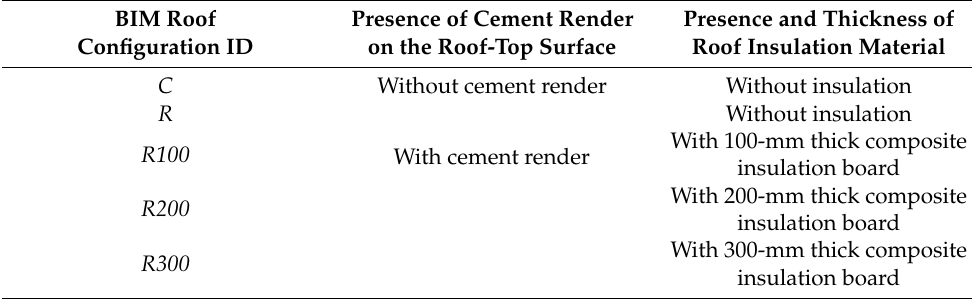
Table 1. Roof configurations of the BIM employed for the simulation